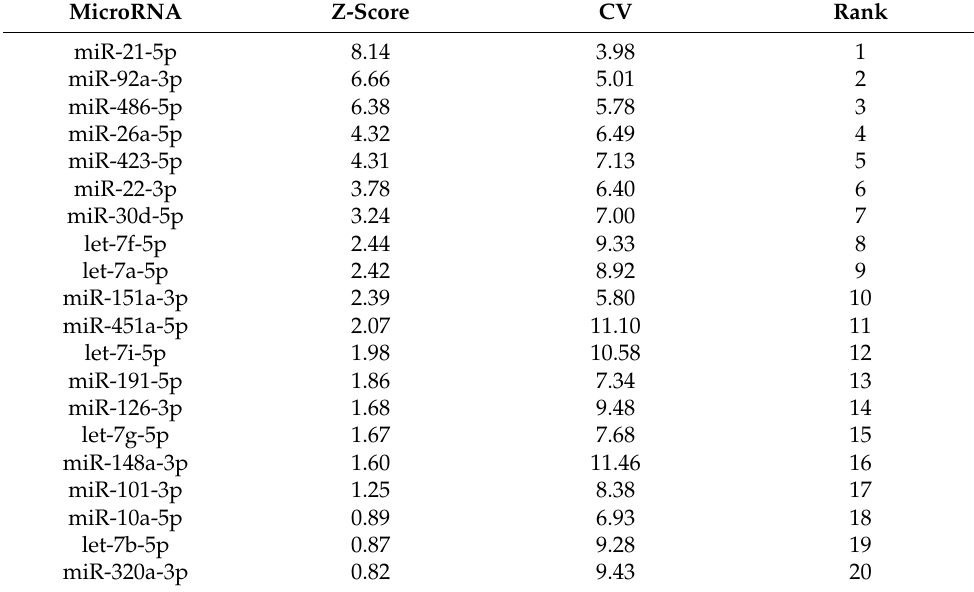
Table 1. Top 20 microRNAs (miRNAs) most stably expressed in plasma exosomes of 69 healthy donor samples according to the Z-score of expression measures. CV: coefficient of